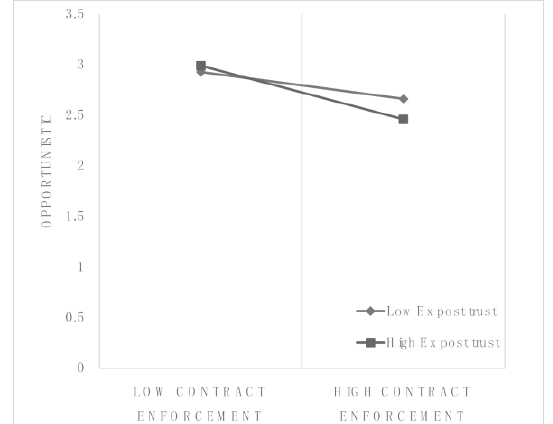
Figure 4. Interaction effect of EPT and CE.